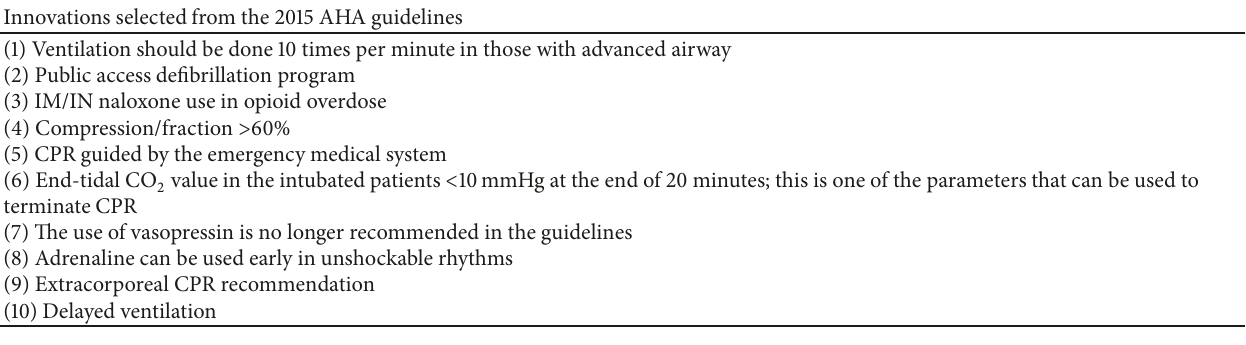
Table 3: Number of excluded